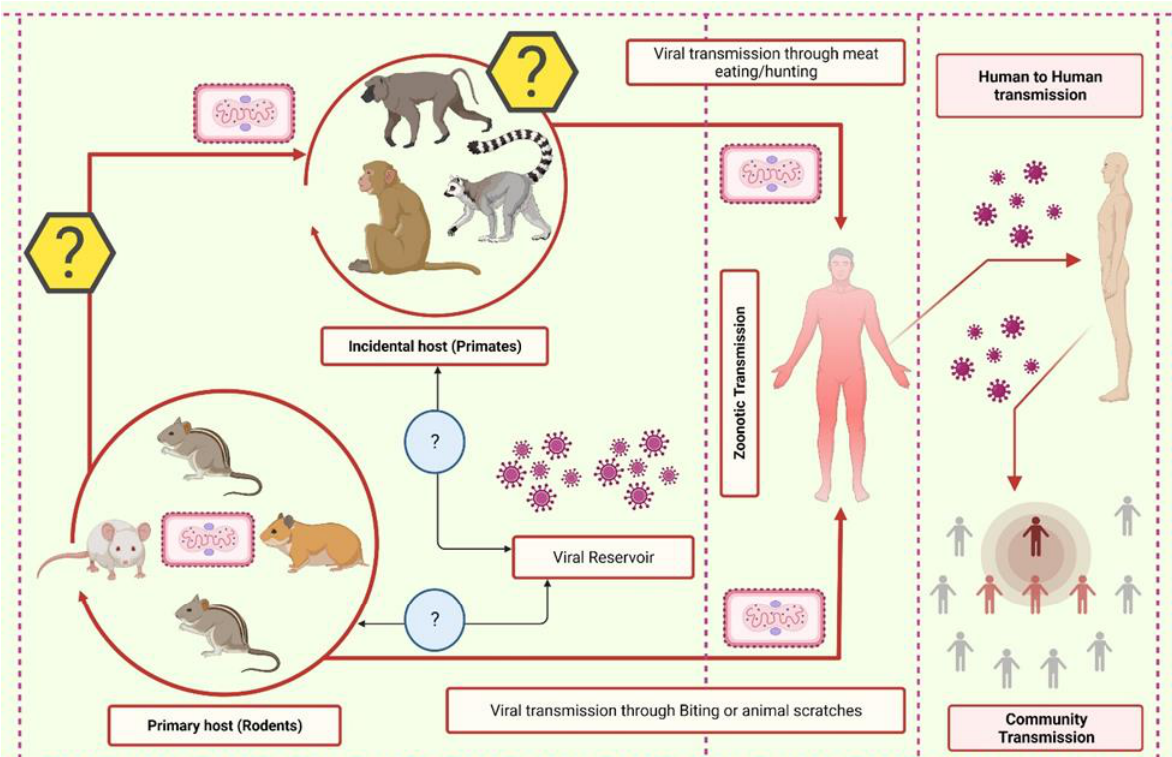
Figure 1. The schematic representation of the transmission cycle of the monkeypox virus. In wildlife, the virus rotates in the primary host and can be transferred to humans through various means. From the primary host, the virus can jump into the incidental host, which in turn can infect the human. Additionally, the reservoir of monkeypox is yet to be elucidated.